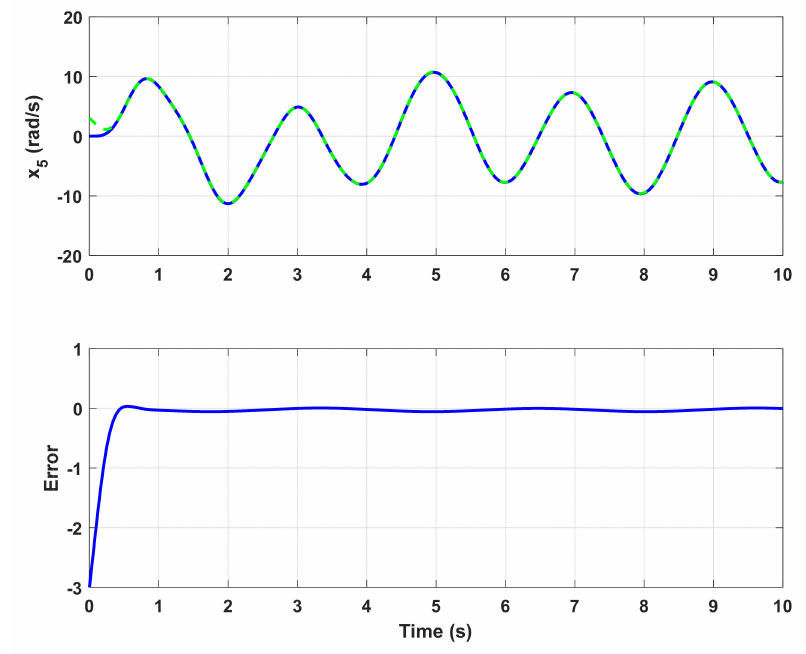
Figure 8. Estimation and error of driver gear